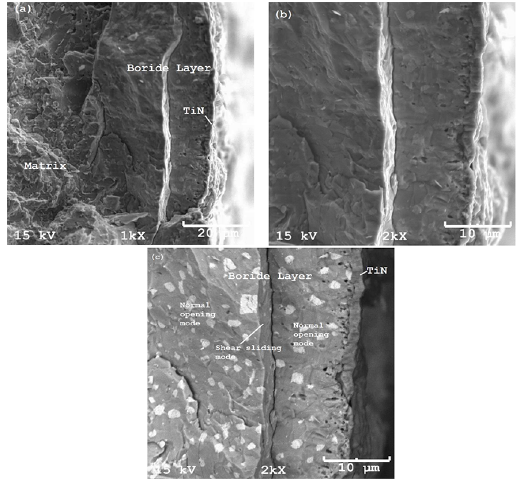
Figure 9. Fracture modes on boride layers (a) 1000x - SE mode, (b) 2000x - SE mode and (c) 2000x - BSE